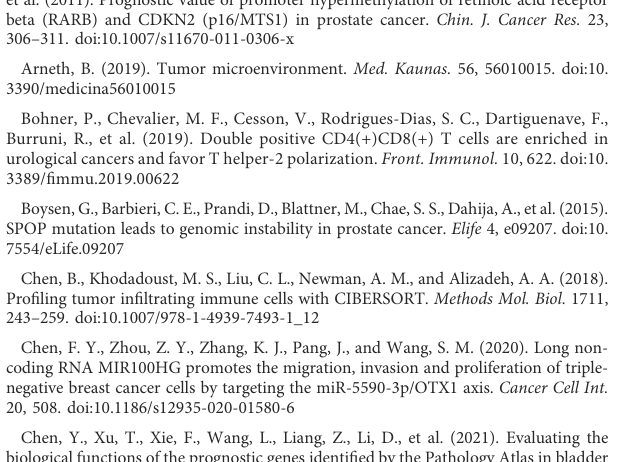
SUPPLEMENTARY FIGURE S1 The forest plot of 14 prognostic lncRNAs. SUPPLEMENTARY FIGURE S2 (A-C) Kaplan-Meier survival analysis of BCR in the low- and high-risk groups for patients with T2, GS > 65, and N1. SUPPLEMENTARY TABLE S1 Primers for qRT-PCR. SUPPLEMENTARY TABLE S2 101 differentially expressed cuproptosis-related